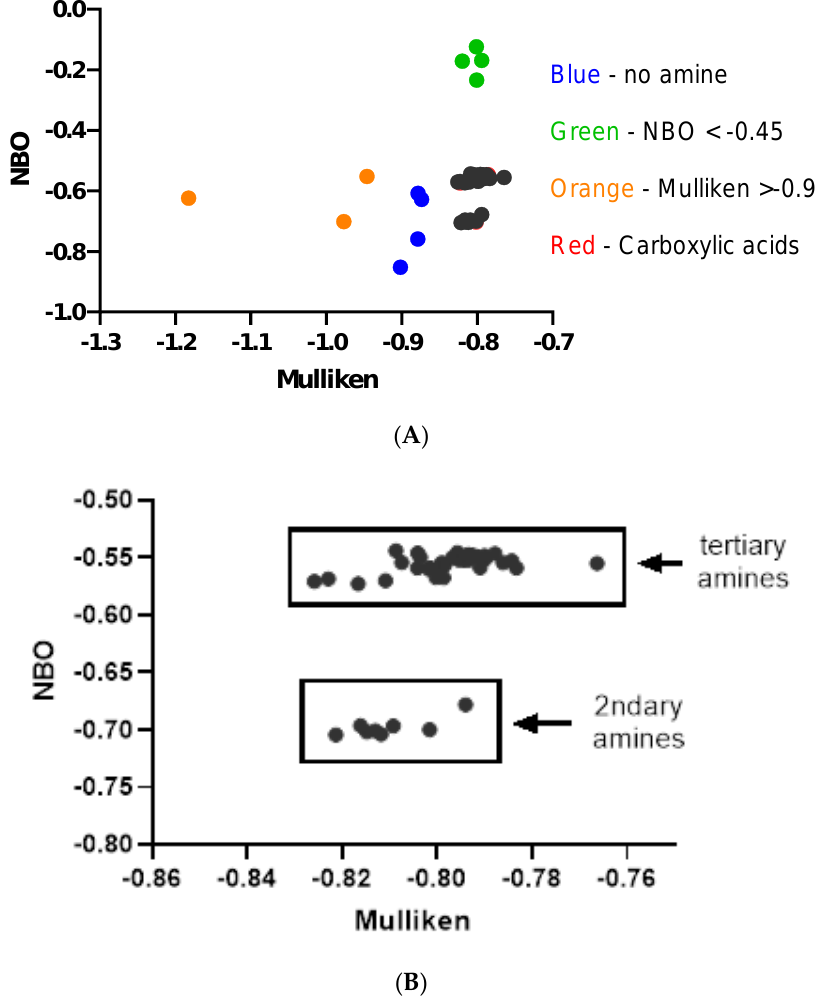
Figure 3. ( A ): Table 1 Compounds HF/321G NBO vs. Mulliken Charge. ( B ): NBO vs. Mulliken Charge, secondary and tertiary amines; Table 1 protonated compounds after questions 1 – 5.